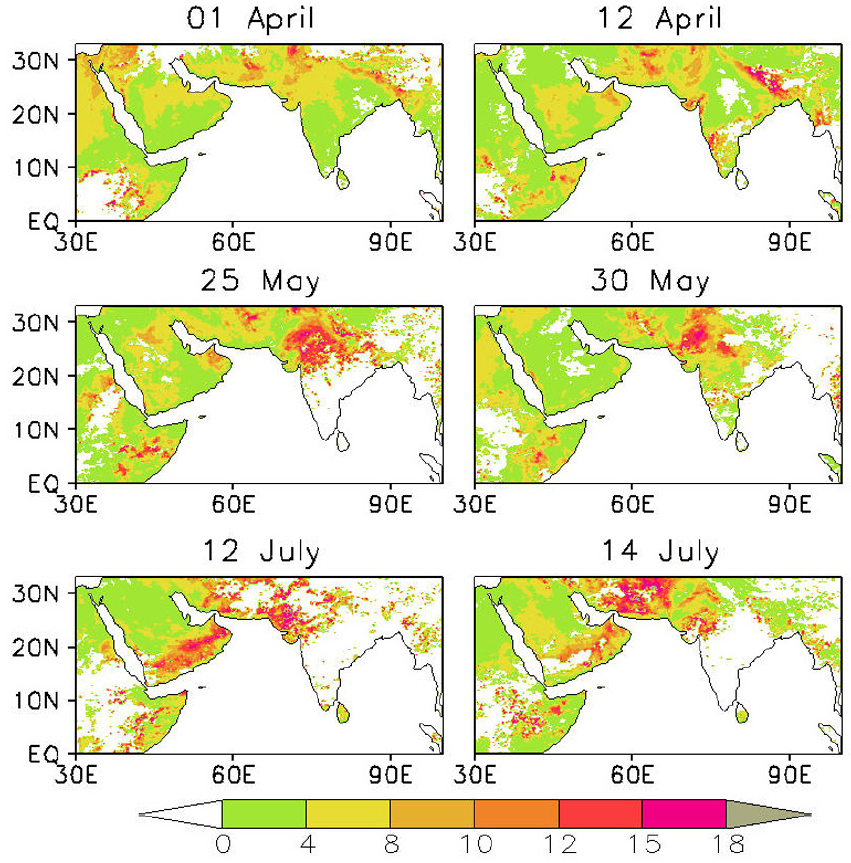
Fig. 15. Typical examples of regional distribution of IDDI (K) during April, May and